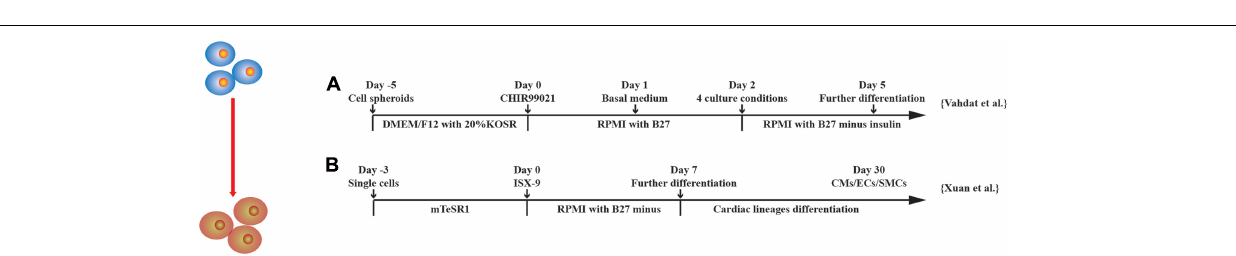
FIGURE 5 | Schematic diagram of differentiation of hPSCs into cardiac progenitor cells. (A) MESP1 + cells were obtained after treatment of GSK3 inhibition and then were cultured in four different conditions: (a) suspension culture of spheroids, (b) adherent culture of spheroids on gelatin, (c) adherent culture of single cells on gelatin, and (d) adherent culture of single cells on Matrigel. (B) Isoxazole (ISX-9), a cardiogenic small molecule, induced CPCs from hPSCs, which further differentiated into three cardiac lineages in vitro